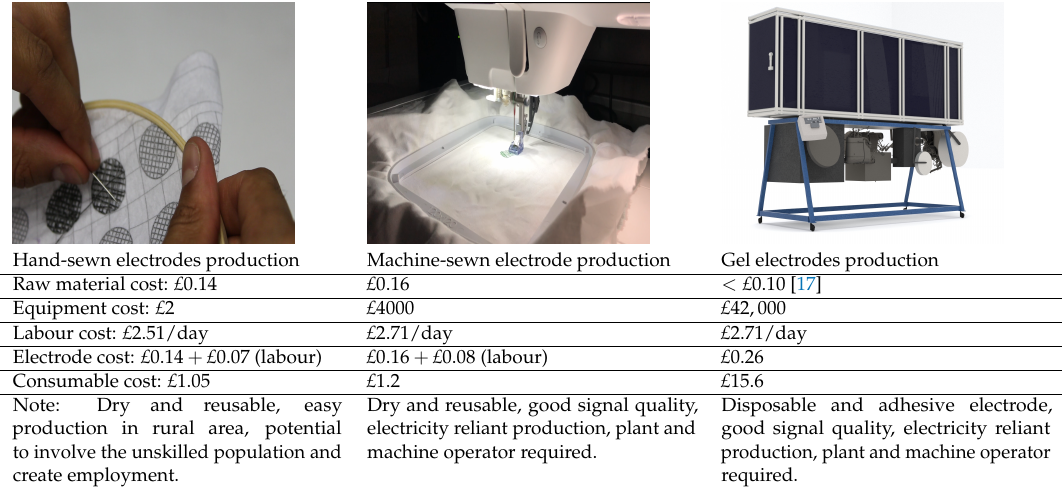
Hand-sewn electrodes